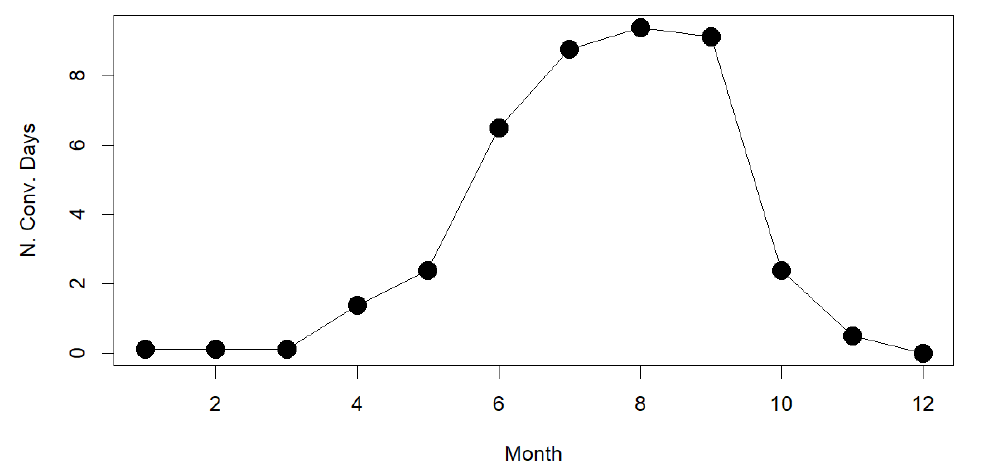
Figure 9. Monthly distribution of convective days according to the occurrence of LJ warnings in Catalonia.